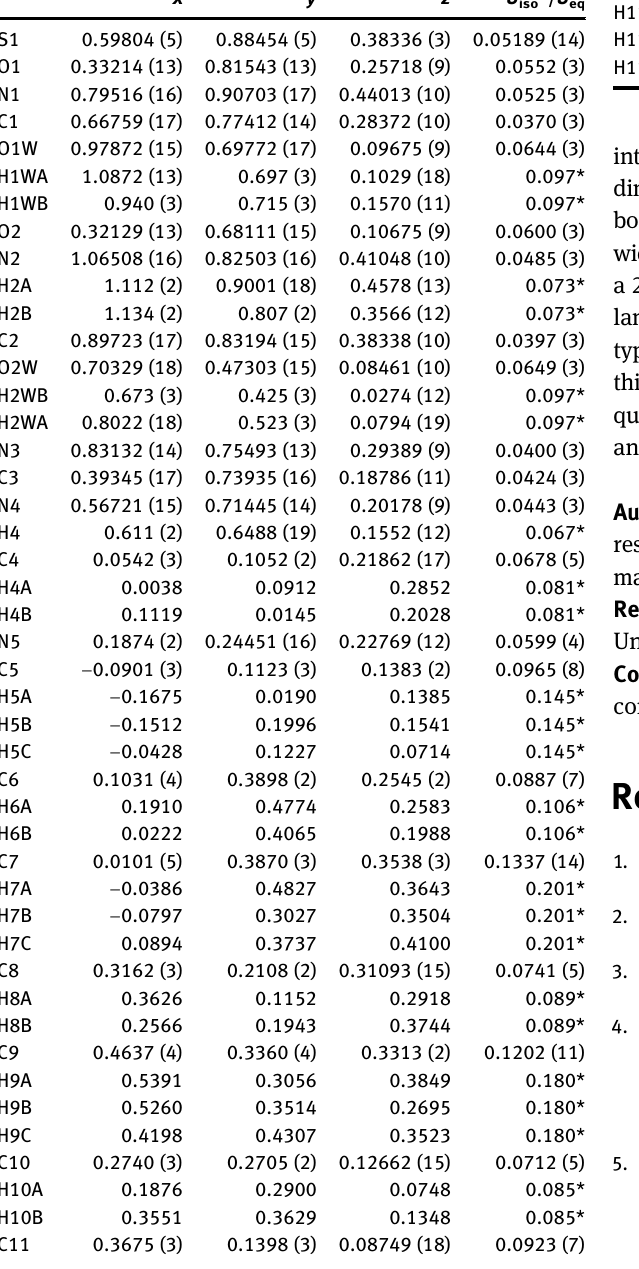
Table  : Fractional atomic coordinates and isotropic or equivalent isotropic displacement parameters (Å 